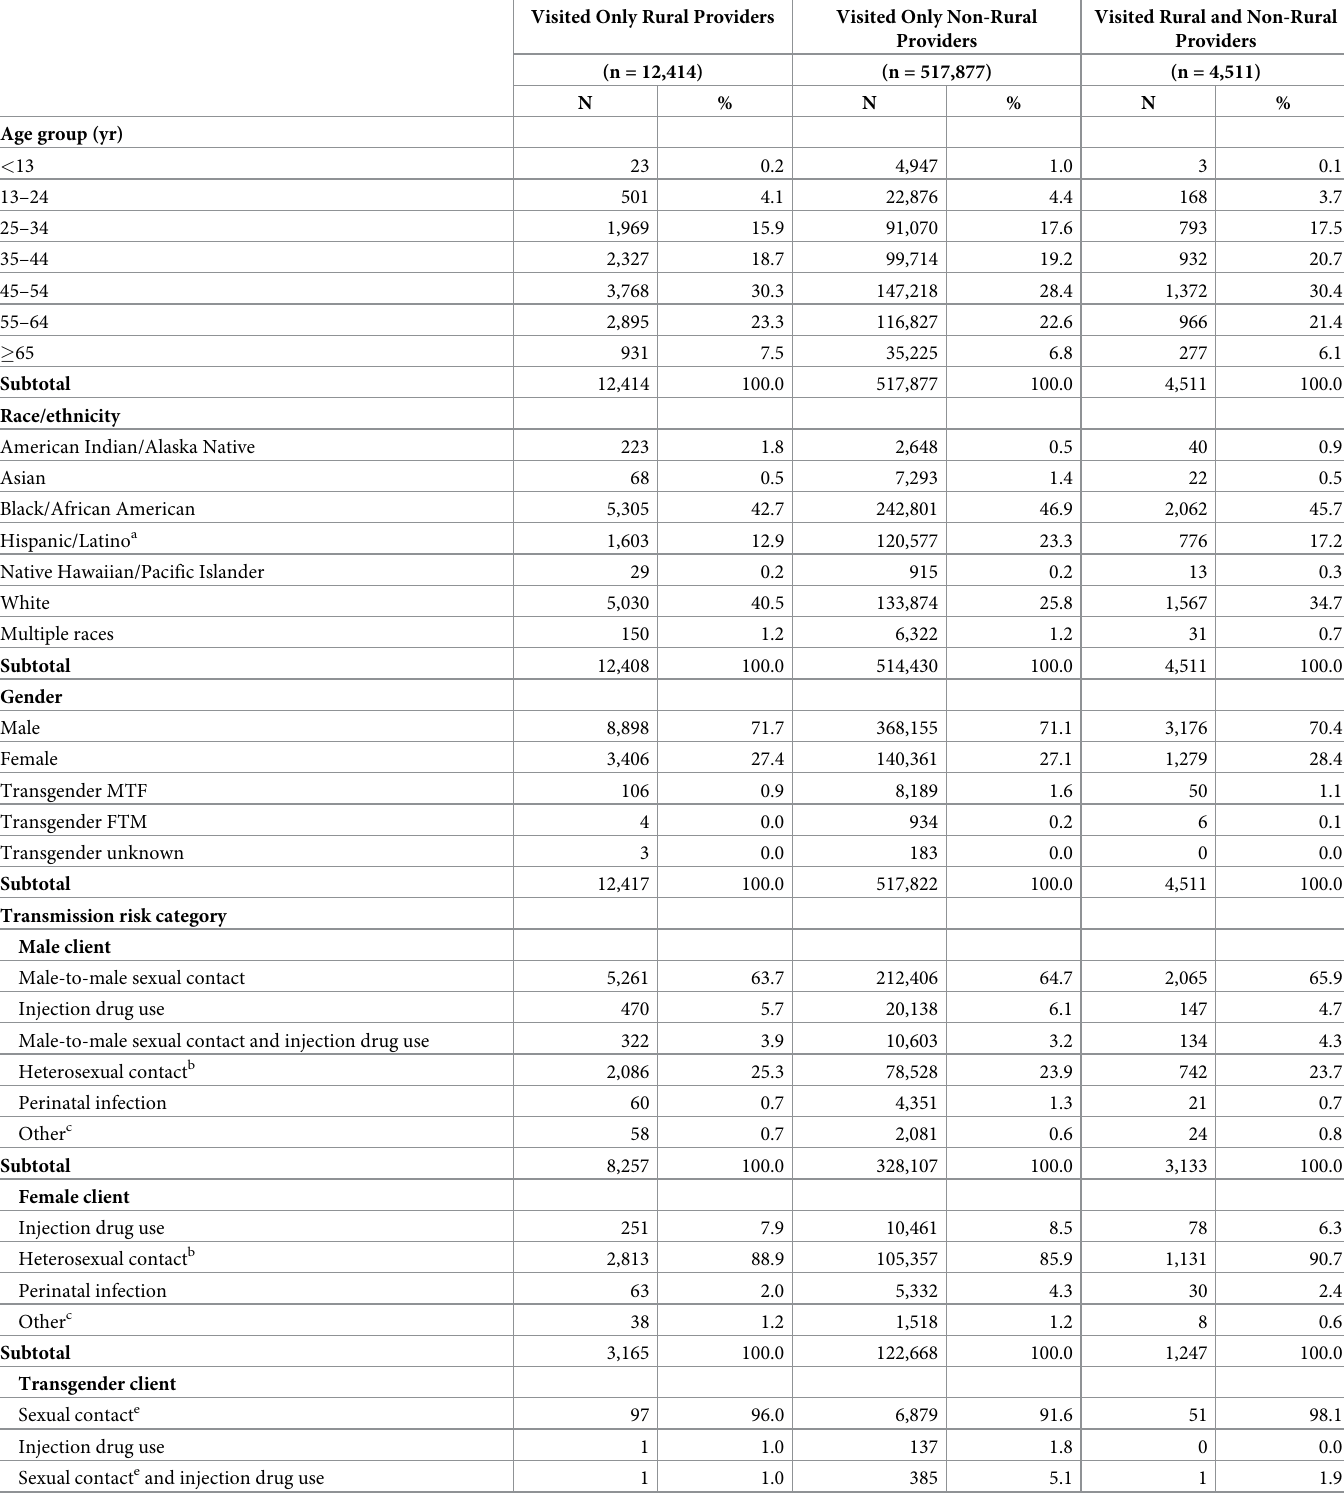
Table 4. Characteristics of RWHAP clients visiting only rural providers, only non-rural providers, and both rural and non-rural providers, 2017.